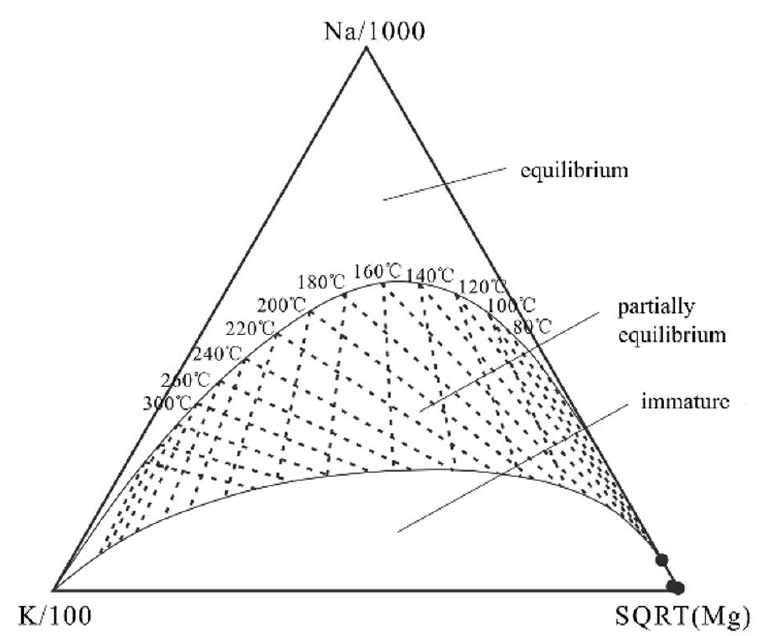
Figure 8. Na-K-Mg three-line diagram of hot spring water chemistry in the study area. Quartz temperature